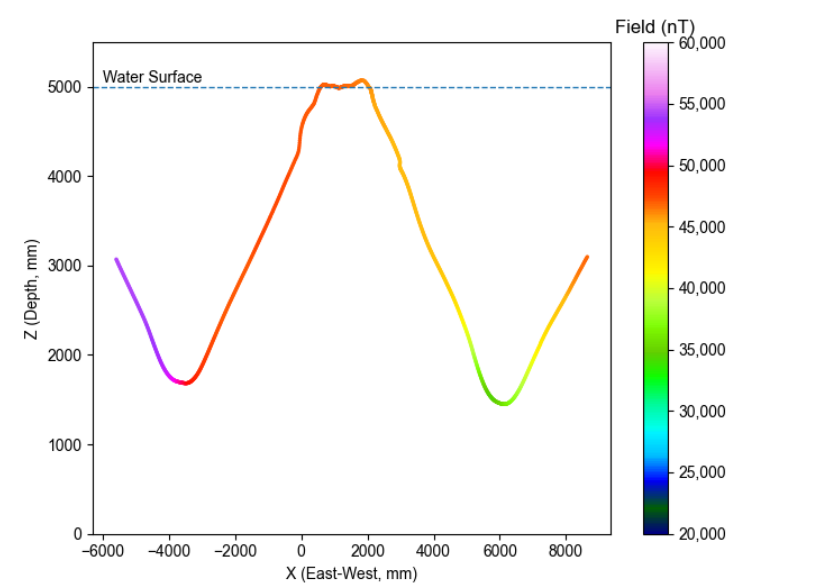
Figure 4. A typical track, viewed from the south wall of the